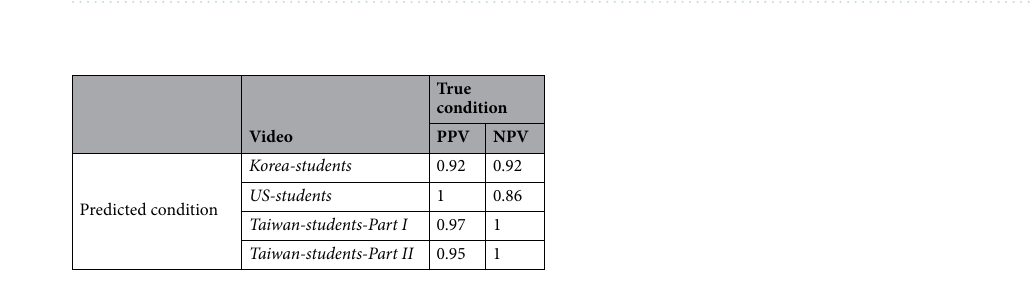
Table 4. Comparison of the predicted results and real conditions of the proposed scheme with the test fragments of Taiwan-students-Part II .